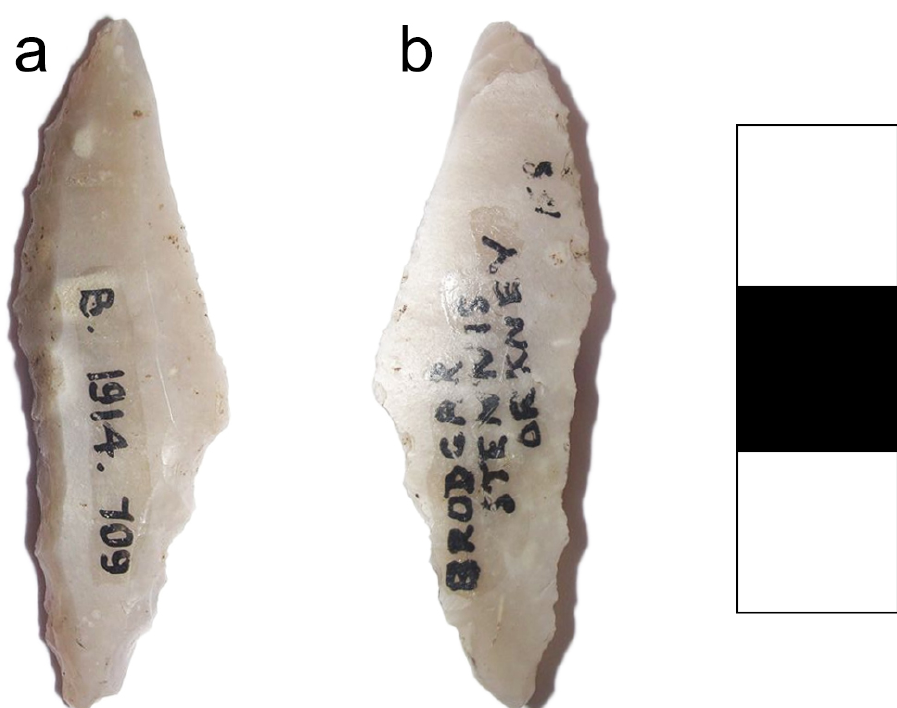
Figure 3. Dorsal and ventral view of the point. 3 cm scale bar. (Photos from The Hunterian Museum and Art Gallery 2006)